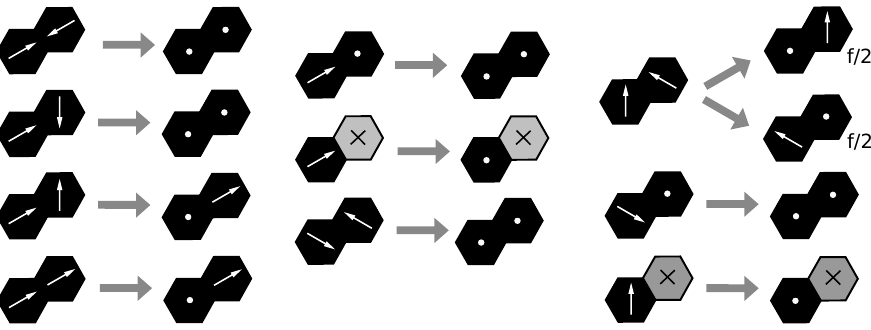
Figure 13. Friction rules for lattice-grain model. Unless otherwise noted, each transition has a rate f , whereas the corresponding transition rates for elastic behavior (Fig. 11) have rate e = 1 − f